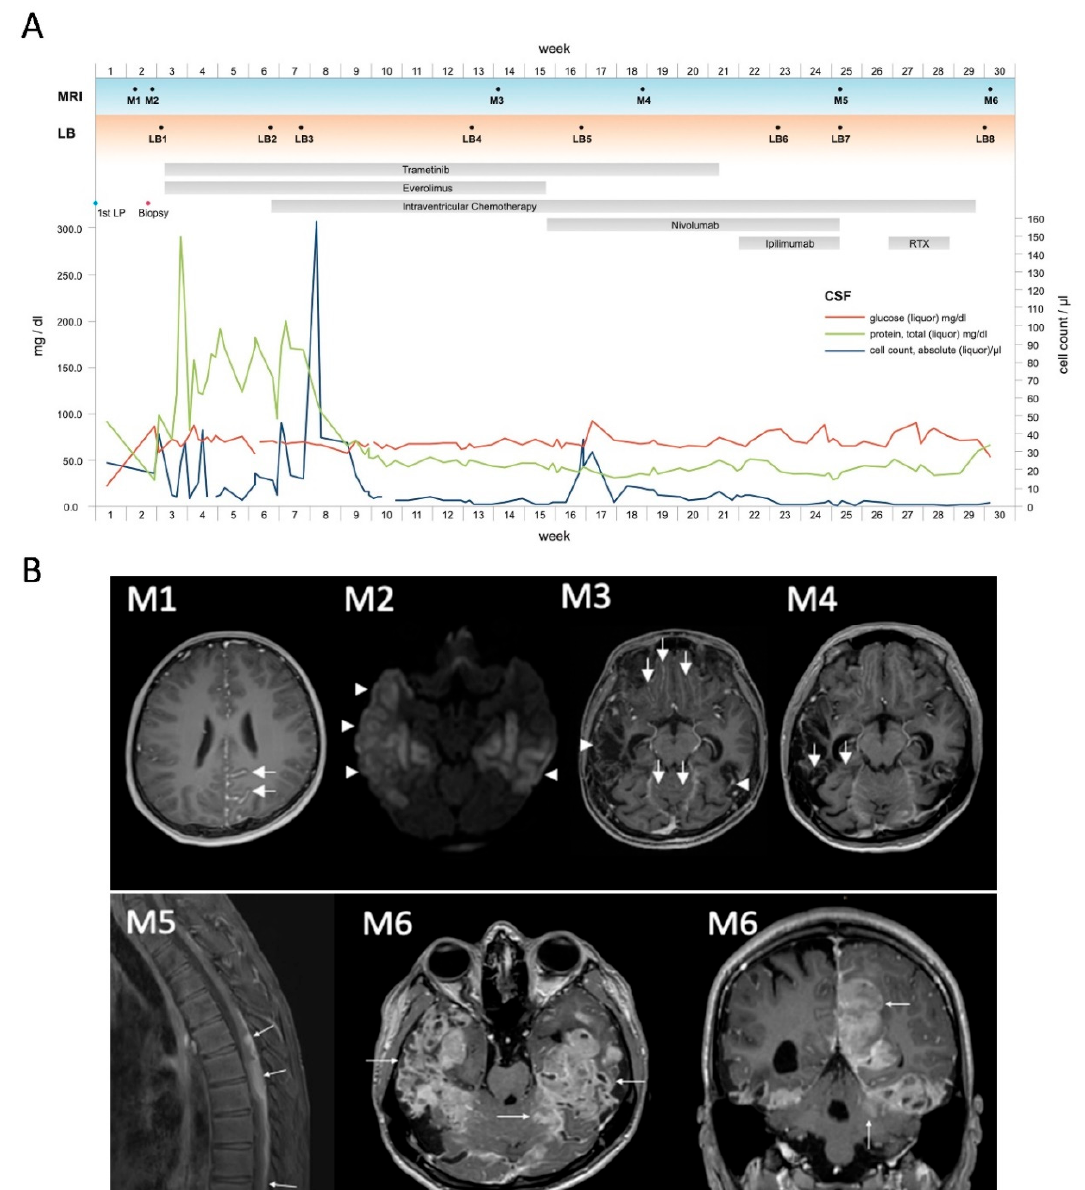
Figure 1. Illustrative case. ( A ) Time course of parameters evaluated in our patient in relation to significant clinical events. Parameters evaluated include CSF values, radiological studies and liquid biopsy results. CSF: cerebrospinal fluid; LB 1–8: timepoints of liquid biopsy; LP: lumbar puncture; RTX: radiotherapy; M1–M6: timepoints of magnetic resonance (MR) imaging exams. ( B ) M1, axial contrast enhanced (CE) T1-weighted MR image at diagnosis showing leptomeningeal contrast enhancement in the left parietooccipital region (arrows); M2, axial image of diffusion weighted imaging (DWI, b1000 map) depicting restricted diffusion in bilateral temporal ischemia (arrow heads) after biopsy; M3, axial contrast enhanced T1-weighted MR image in week 14 demonstrating leptomeningeal enhancement in frontobasal and cerebellar sulci (arrows). Note the postischemic parenchymal defects (arrow heads). M4, Axial CE T1-weighted MR image in week 18 showing progression of leptomeningeal enhancement in cerebellar sulci. M5, Sagittal T1-weighted contrast enhanced image with fat suppression demonstrating dorsally located perimedullary spread of the disease (white arrows) with infiltration of the thoracic spinal cord. M6, T1-weighted contrast enhanced images in axial and coronal plane showing progressive disease with large confluent leptomeningeal and superficial parenchymal lesions (arrows). Note that they are also occupying the postischemic defects in the temporobasal region.